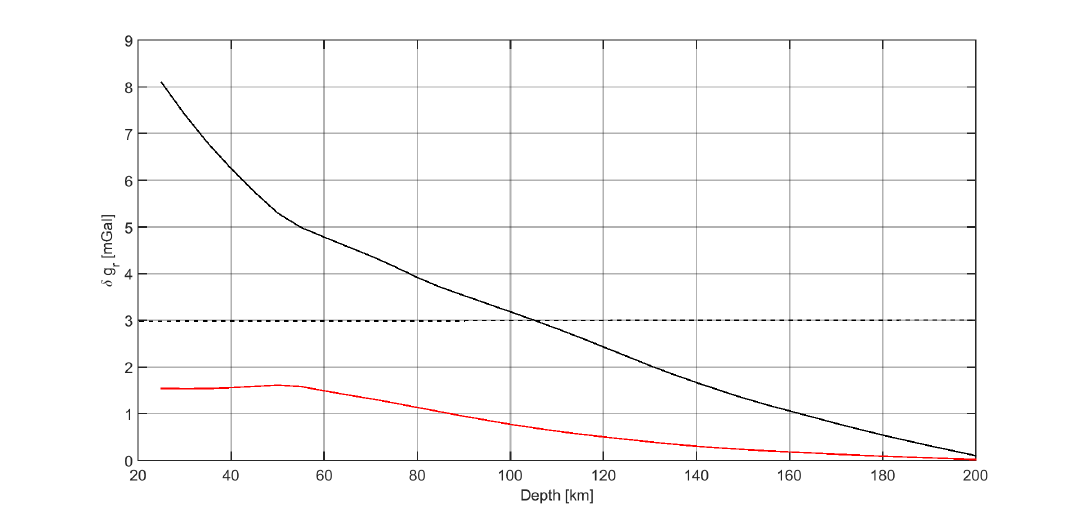
Figure 3. Omission error STD (black solid line) as a function of the maximum depth of the model and 1 σ accuracy of the mantle gravitational effect (red solid line) from ˆ z − of ˆ z V